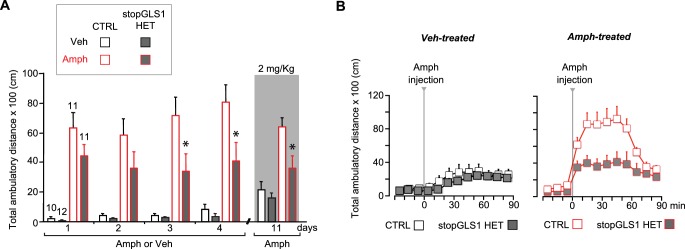
stopGLS1 HET with a global PAG reduction show attenuated amphetamine sensitization.(A) While potentiation of LI is seen in stopGLS1 mice (Gaisler-Salomon et al., 2009b), amphetamine sensitization had not been tested. To test for amphetamine sensitization in stopGLS1 HET mice, Amph (4 mg/kg) or Veh was administered over 4 consecutive days. Amph-treated CTRL mice showed a sensitized response to Amph while Amph-treated stopGLS1 HET mice did not. A three-way RM ANOVA revealed a significant day X genotype interaction (F(3,120) = 3.4, p=0.021, ES partial η2 = 0.078), a treatment X genotype interaction (F(1,40) = 5.85, p=0.020, ES partial η2 = 0.128), and a trend for a day X treatment X genotype interaction (F(3,120) = 2.6, p=0.058, ES partial η2 = 0.060). Analysis of genotype and treatment effects on each day revealed significant genotype X treatment interactions on Day 3 (F(1,40) = 7.68, p=0.008, ES partial η2 = 0.161) and Day 4 (F(1,40) = 7.00, p=0.012, ES partial η2 = 0.149), but not on Days 1 or 2. Analysis of simple effects on Days 3 and 4 revealed a genotype effect within the Amph-treated groups indicated by * (Day 3, F(1,20) = 8.29, p=0.009, ES partial η2 = 0.313; Day 4, F(1,20) = 9.13, p=0.007, ES partial η2 = 0.616). One week later (Day 11), all mice received a lower challenge dose of Amph (2 mg/kg; gray shading). Amph-treated CTRL mice showed a significantly increased response to Amph compared to Veh-treated CTRL mice, revealing sensitization. In contrast, Amph-treated stopGLS1 HET mice showed a slightly increased response to Amph compared to Veh-treated stopGLS1 HET mice, showing reduced expression of sensitization. A two-way ANOVA revealed a significant treatment X genotype interaction (F(1,40) = 4.5, p=0.039, ES partial η2 = 0.103). Analyses within each genotype, showed a significant effect of drug treatment for CTRL mice (F(1,19) = 24.8, p<0.001, ES partial η2 = 0.566), and a trend for treatment in stopGLS1 HET mice (F(1,21) = 4.1, p=0.055, ES partial η2 = 0.164). * indicates significantly different from Amph-treated CTRL mice, analyses of simple main effects. (B) Time course of Amph-induced locomotion for CTRL and stopGLS1 HET mice on the challenge day (Day 11). There were no genotypic differences in baseline activity, prior to Amph injection. After Amph injection, Veh-treated mice — receiving Amph for the first time — showed a modest locomotor response that did not differ genotypically (left graph). Amph-treated mice showed a robust locomotor response to Amph, greater in CTRL than stopGLS1 HET mice (right graph). These differences were supported by a RM ANOVA within each treatment, showing no time X genotype interaction for Veh-treated mice (F(8,160) = 0.782, p=0.619), but a significant time X genotype interaction for Amph-treated mice (F(8,160) = 3.9, p<0.0001, ES partial η2 = 0.165). Taken together, these results indicate that stopGLS1 HET mice show attenuated amphetamine sensitization. Numbers of mice are shown above the bars. Abbreviations: Amph - amphetamine; Veh - vehicle. See Figure 6—figure supplement 1—source data 1.xlsx for source data and statistical analysis.DOI:
http://dx.doi.org/10.7554/eLife.27566.024
10.7554/eLife.27566.025Figure 6—figure supplement 1—source data 1.Amphetamine sensitization in stopGLS1 HET mice .